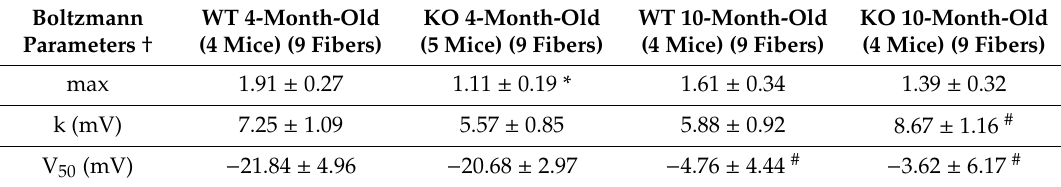
Table 1. Parameters describing the voltage dependence of the depolarizing pulse-evoked Ca 2+ transients in WT and sAnk1 KO fibers.